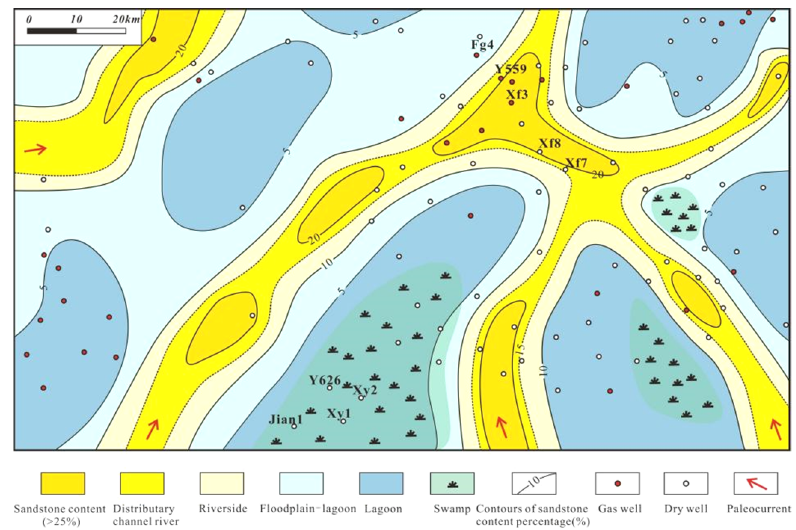
Figure 13. Sedimentary facies map of the Taiyuan Fm. in the southeastern Ordos Basin.